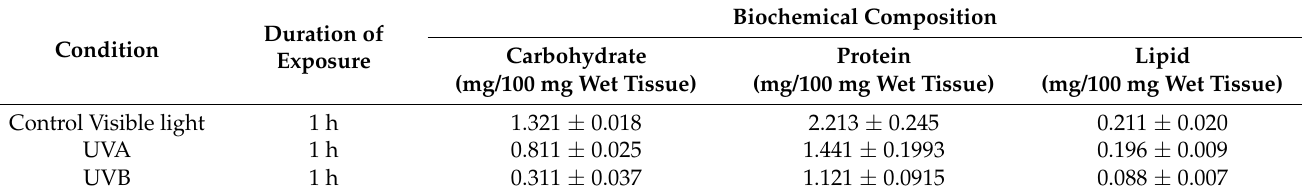
Table 3. The biochemistry of muscle tissue altered when exposed to UV rays—for example, compared with the control, the carbohydrate, protein, and lipid contents are drastically affected after 1 h of expo- sure to both UVA and UVB rays. For instance, carbohydrate in control sample is at 1.321 mg/100 mg of wet tissue, but when irradiated with UVA at 3.9 eV, the carbohydrate content is 0.882 mg/100 mg wet tissue, and when irradiated with UVB, the carbohydrate figures are even less, i.e., 0.311 mg/100 mg wet tissue. This trend was repeated with protein and lipid content. Biochemically, UV radiation with more energetic photons (e.g., UVB) had greater effects on fish